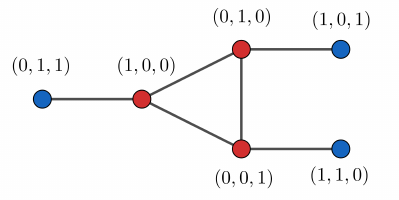
Figure 1. Diagram of the graph Γ ( Z 2 × Z 2 × Z 2